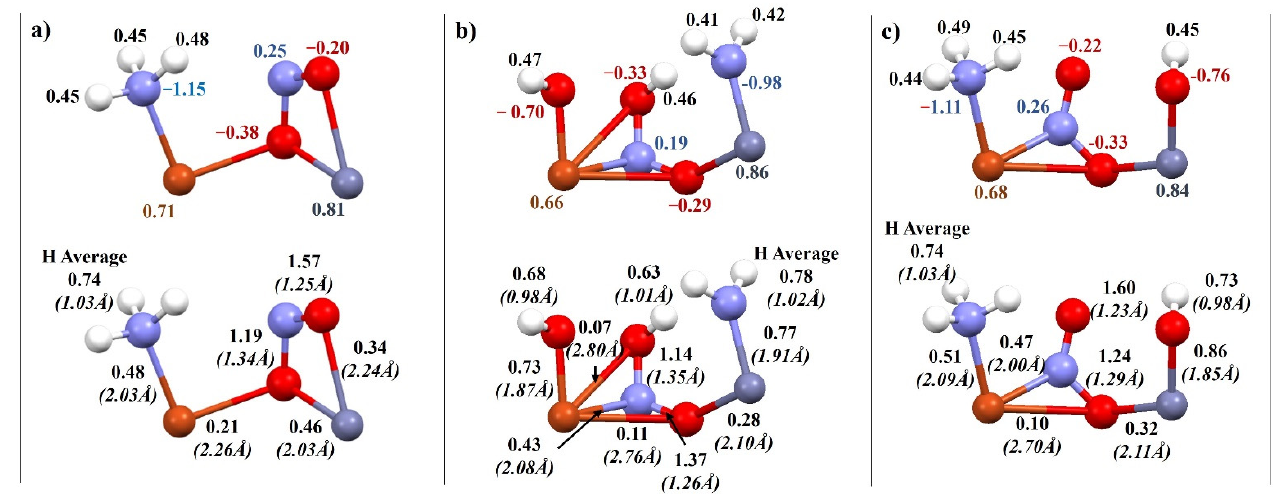
Figure 8. Charge distribution (above), bond order and length—bracketed (below) for coadsorption of NO and NH3 on metallic Cu–Zn dimers in MFI: ( a ) Cu–Zn bimetallic dimer, ( b ) Cu–Zn bimetallic dimer with OH group on Cu, ( c ) Cu–Zn bimetallic dimer with OH group on Zn.